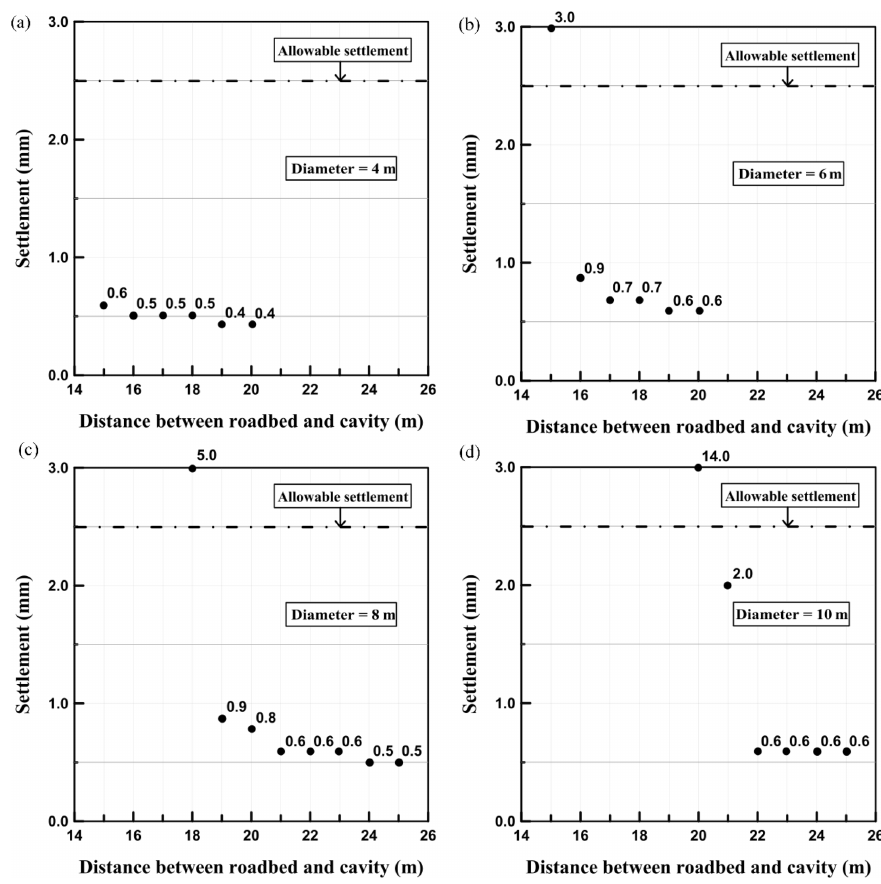
Figure 6. Roadbed settlement with respect to the distance between roadbed and cavity: (a) diameter = 4m, (b) diameter = 6m, (c) diame- ter = 8m and (d) diameter = 10m.